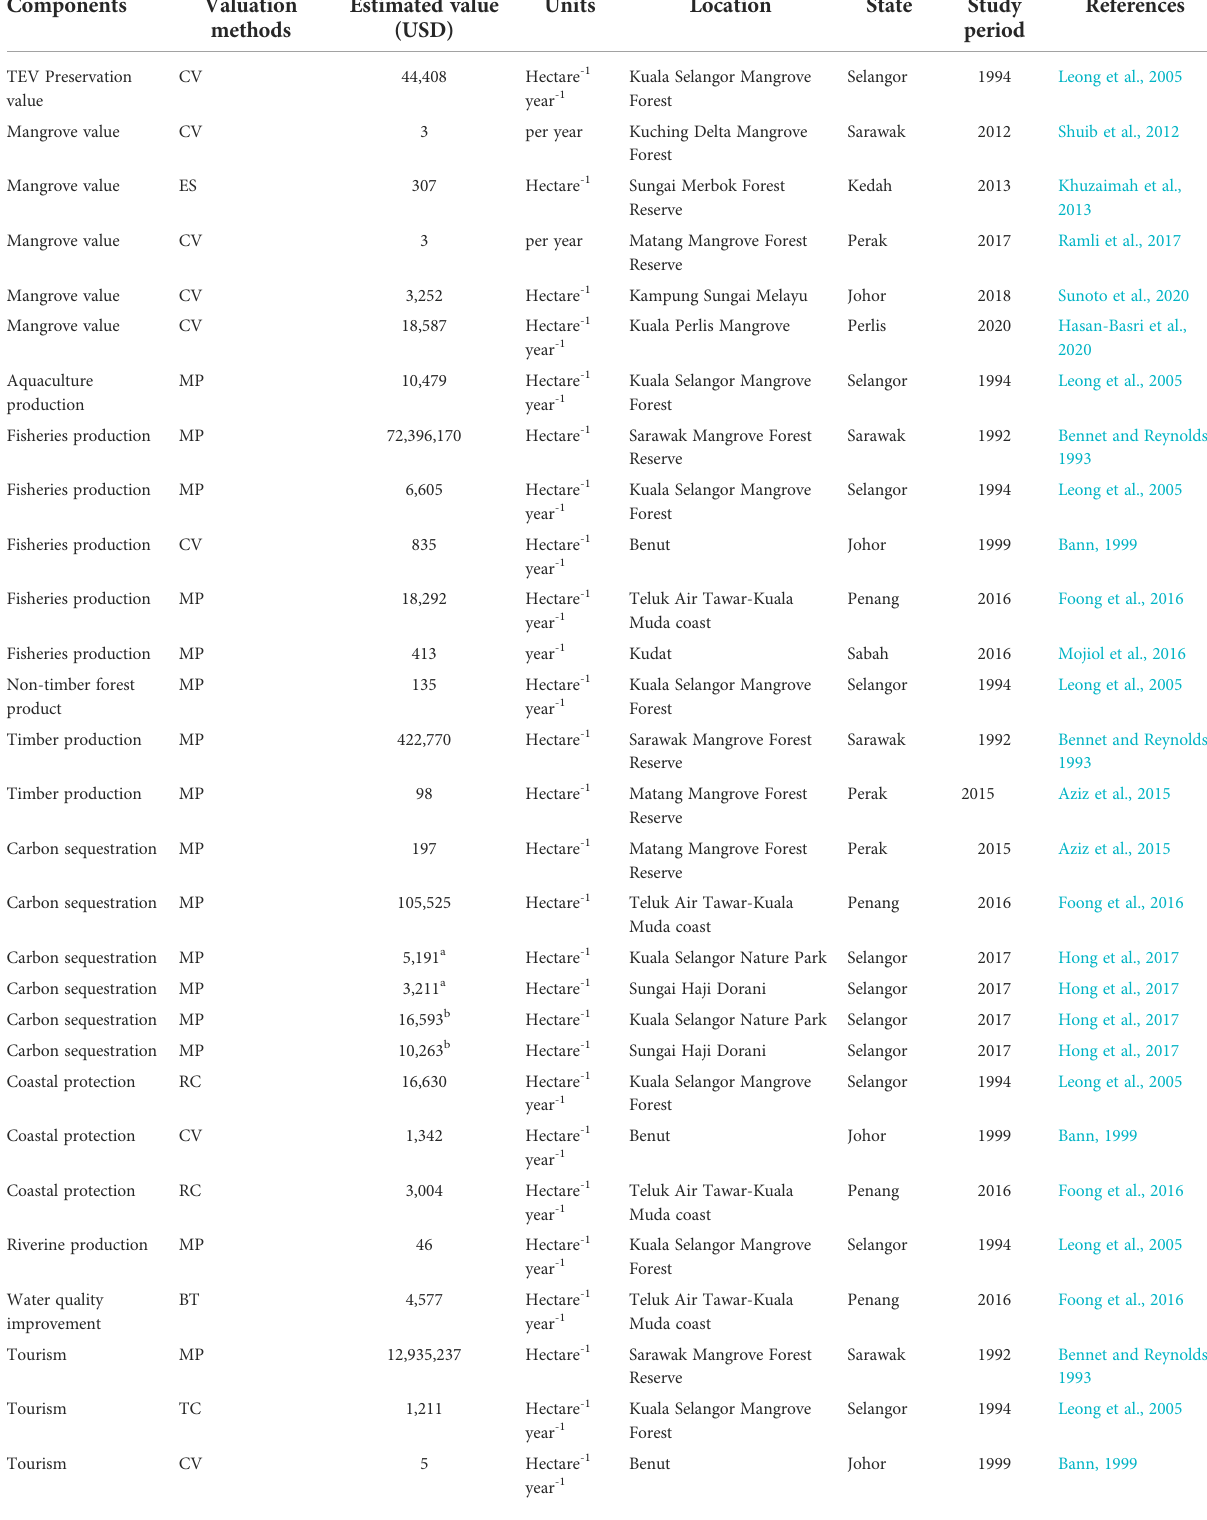
TABLE 1 Summary of mangrove ecosystem service valuation in